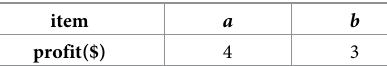
Table 2. External utility